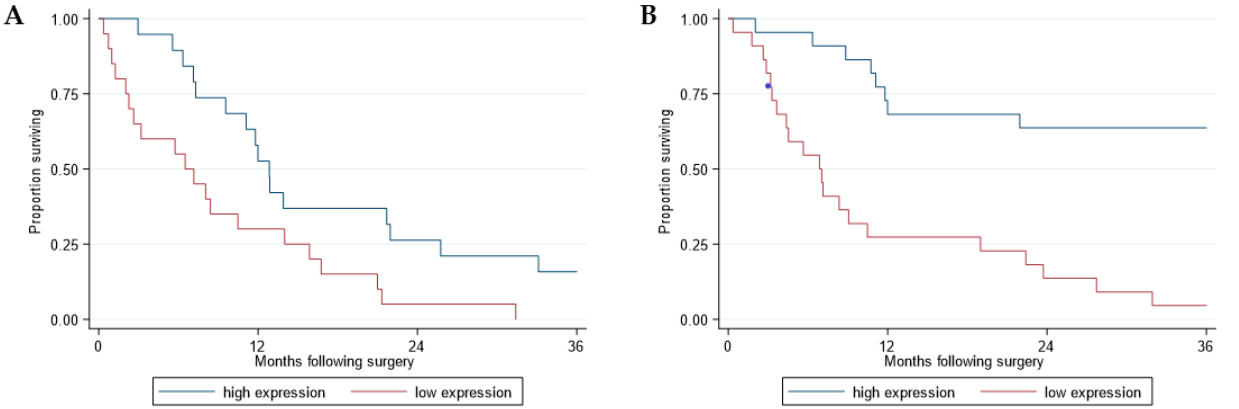
Figure 1. Survival analysis of the patients with malignant pleural mesothelioma (MPM) included in the Sentrix and Code-Link datasets according to RERG expression levels. Kaplan-Meier curves of overall survival according to RERG expression in the Sentrix ( n = 39) ( A ) and CodeLink ( n = 44) ( B ) datasets. Red and blue curves represent RERG expression lower and higher than the median levels, respectively. Overall survival was calculated from date of surgery. Survival curves were truncated at 36 months.